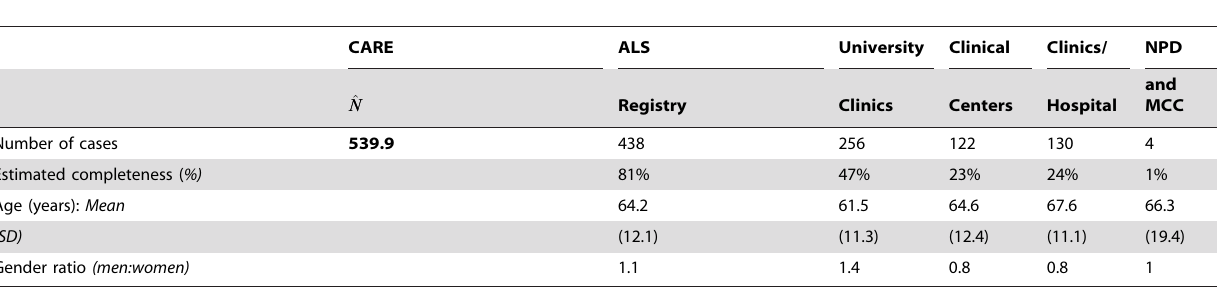
Table 2. Demographic characteristics of the observed ALS cases in the data